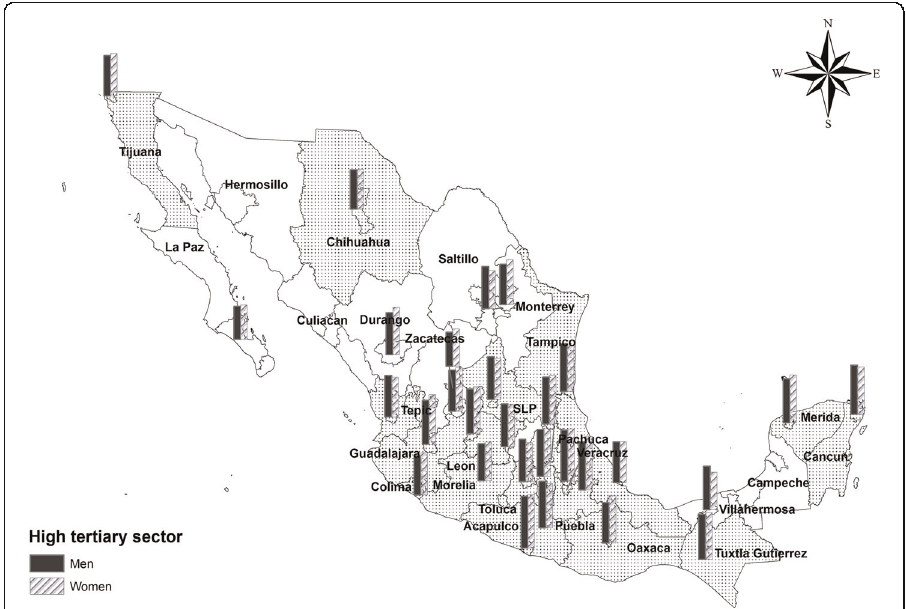
Fig. 3 Precariousness in the high-tertiary sector, 2018. Source: Author ’ s extrapolation with data from the ENOE